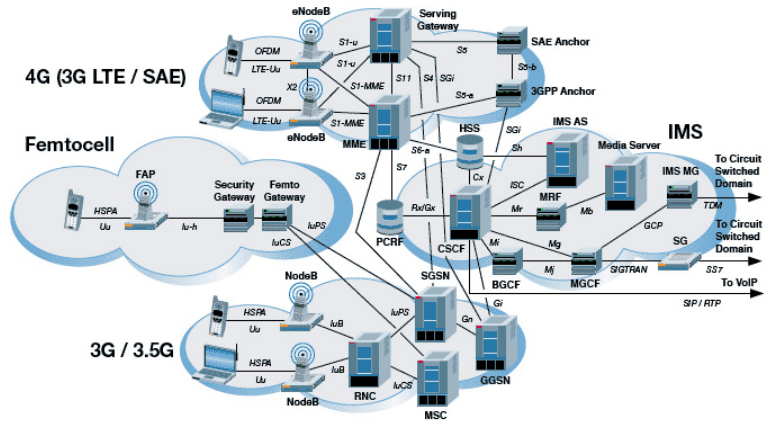
Figure 1. A typical cellular network architecture.